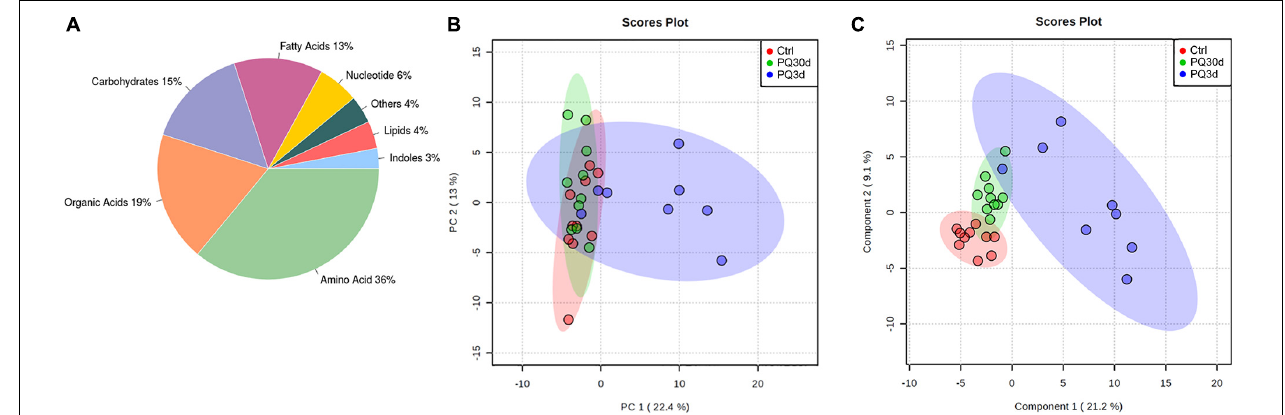
FIGURE 1 | Overviews of metabolic profiles. (A) Metabolite classes and compositions detected in the samples. Overview of metabolic profiles of Ctrl, PQ30d, and PQ3d groups using principal component analysis (PCA) (B) and partial least squares discriminant analysis (PLS-DA) (C) score plots for serum samples analyzed by